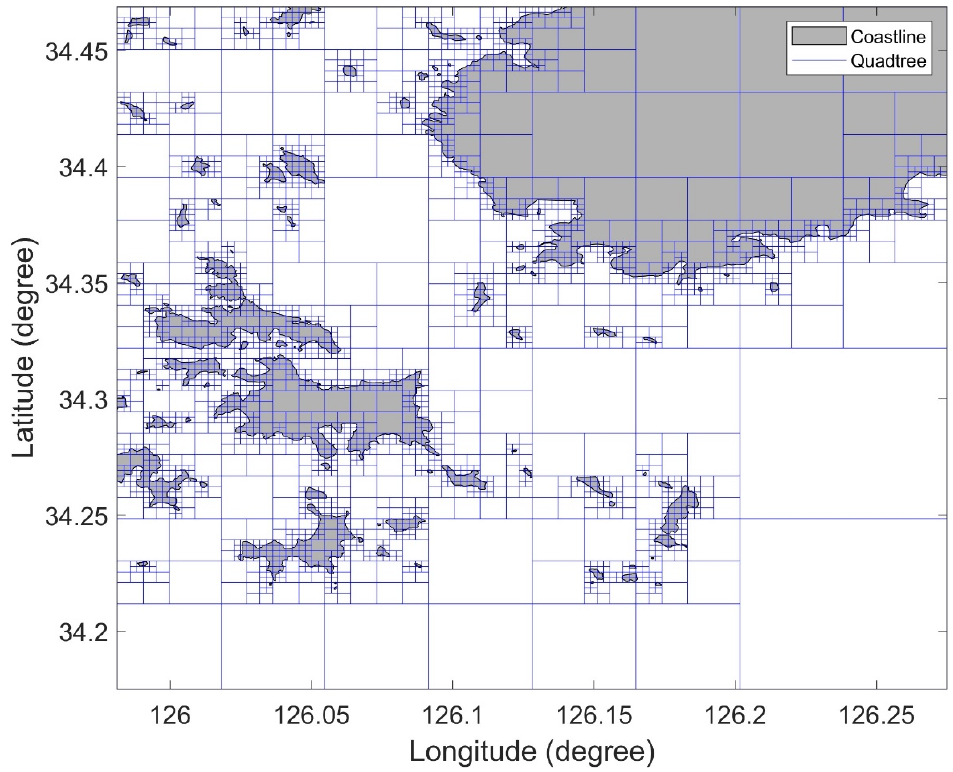
Figure 3. Detailed view of Zone 1 in Figure 2.